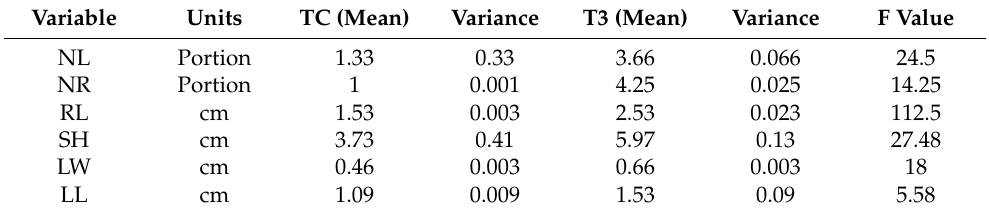
Table 2 Phenological study for TC and T3. Table 2. The phenological study between the best treatment, after 4 weeks of observation under in vitro growth conditions whit a meaningful level of p ≤ 0.05.